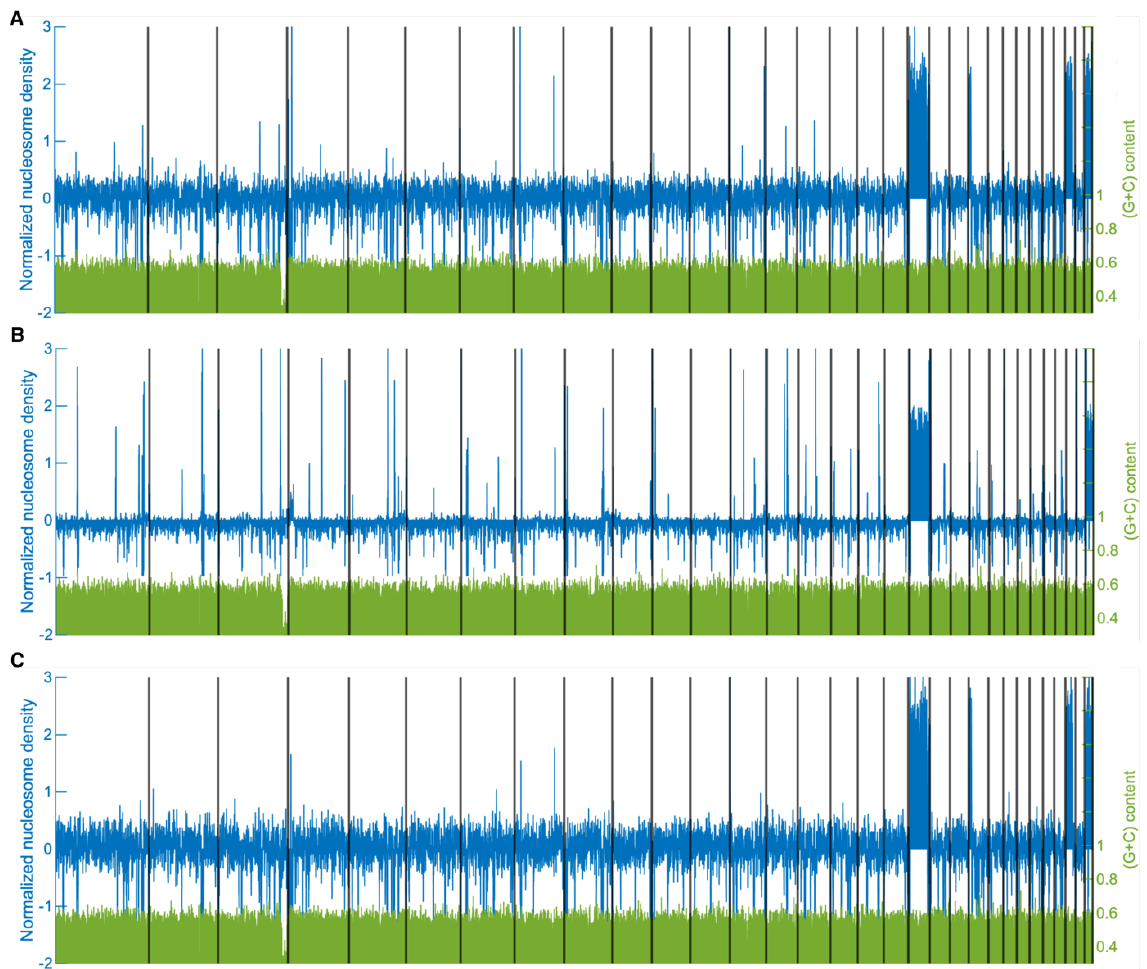
Supplementary Figure 6. Normalized nucleosome density profiles vs . AT content in individual biological replicates of Leptosphaeria maculans ‘lepidii’. Coverage density profiles were computed for non-overlapping 1 kb-long bins along all supercontigs, separated by black lines. AT-rich 1 kb-long bins are plotted in green, with no isochore visible. In blue are plotted the z-scored average nucleosome density profile ( A). Biological replicate #1; ( B). Biological Replicate #2; ( C). Biological replicate